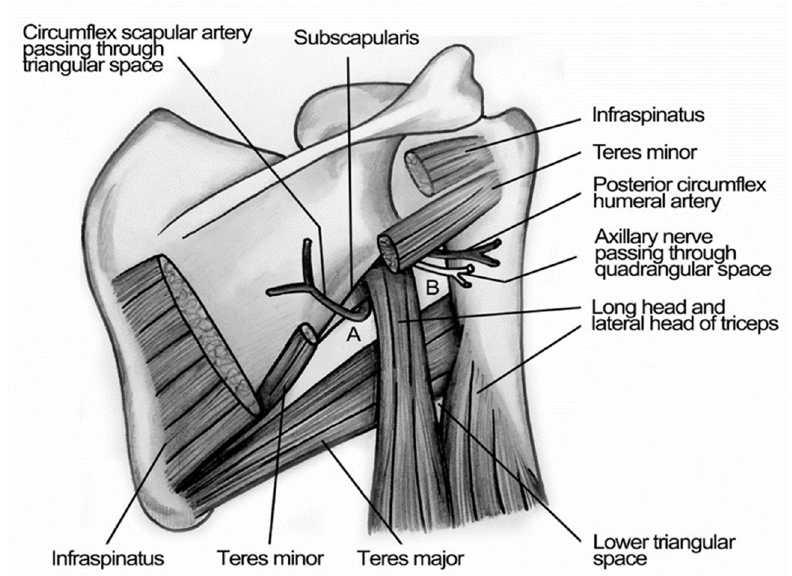
Figure 7. Illustration of Triangular Intramuscular Space (TIS). Subscapular spaces. A: Triangular Intermuscular Space (TIS); superior border: lower margin of Teres Minor, inferior border: upper margin of Teres Major, lateral border: medial margin of the long head of Tricepts. B: Quadrangular Space of Velpeaum; superior border: inferior margin of Teres Minor, inferior border: superior margin of Teres Major, medial border: medial margin of the long head of Triceps, lateral border: medial margin of shaft of Humerus.